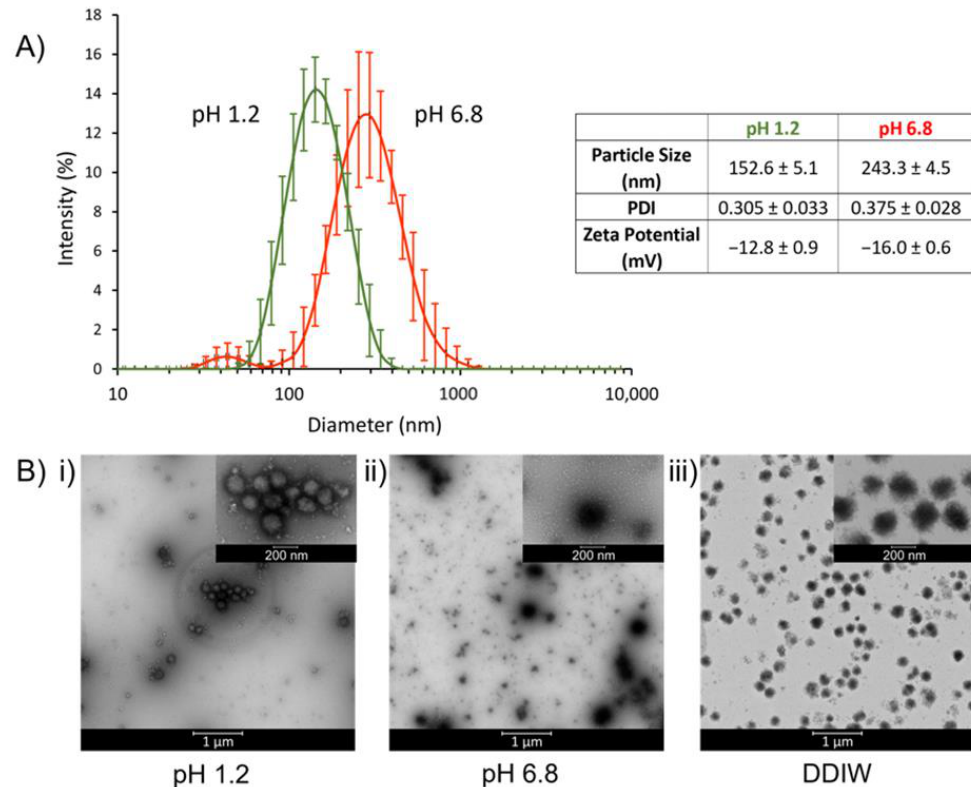
Figure 2. ( A ) Intensity-weighted hydrodynamic diameter and zeta potential of TPN of midpoint composition at pH 1.2 and pH 6.8. ( B ) TEM photographs of TPN with the midpoint composition dispersed in (i) 0.1 N HCl (pH 1.2), (ii) pH 6.8 phosphate buffer, or (iii) DDIW. The nanoparticles were stained with 2% uranyl acetate and dried on carbon-coated copper grids.